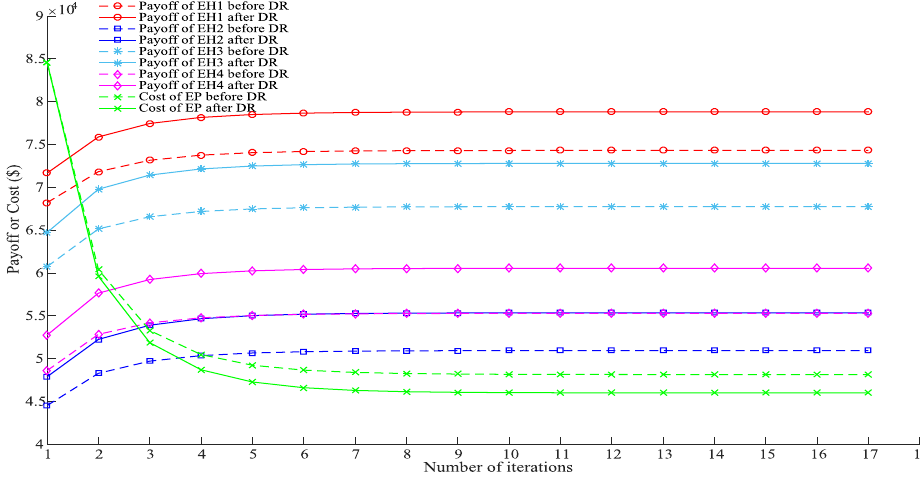
Figure 10. The convergence processes of energy prices: ( a ) The convergence processes of electricity prices without DR; ( b ) The convergence processes of electricity prices with DR; ( c ) The convergence processes of gas prices without DR; ( d ) The convergence processes of gas prices with DR.